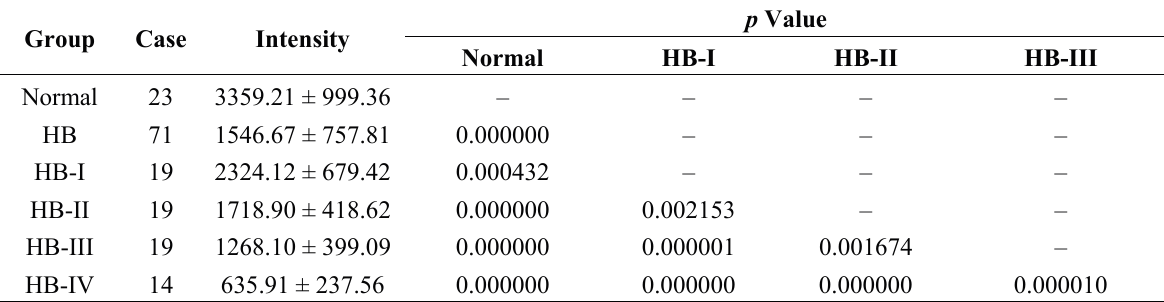
Table 2. SELDI-TOF-MS mass spectrometry analysis of proteins or peptide segments with an m / z of 9348 Da in the normal and HB